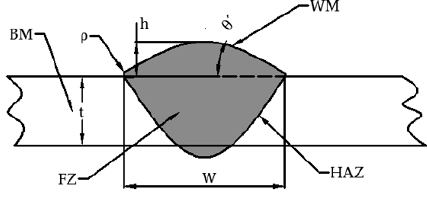
Figure 2. Schematic diagram of the butt joint.